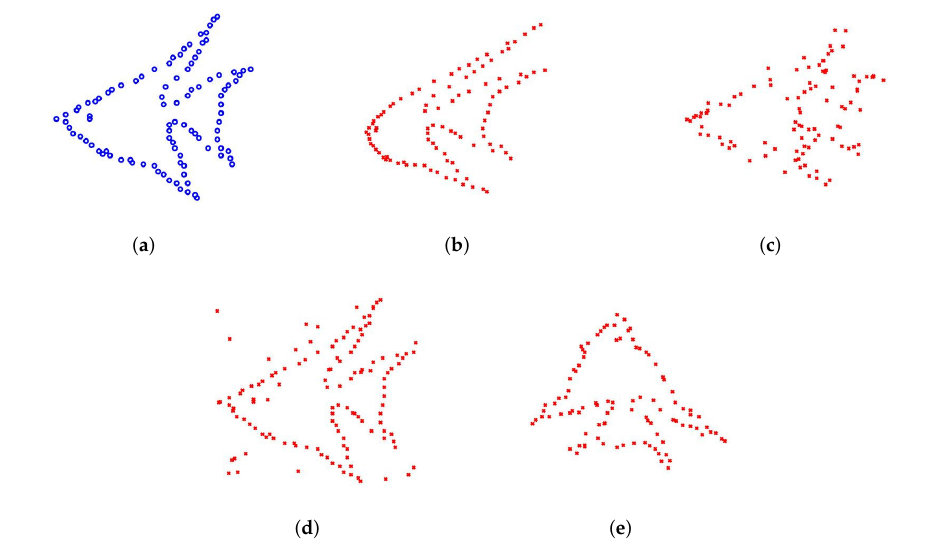
Figure 2. ( a ) shows model fish point sets, and ( b – e ) show point sets added with deformation, noise, outliers, and rotation,